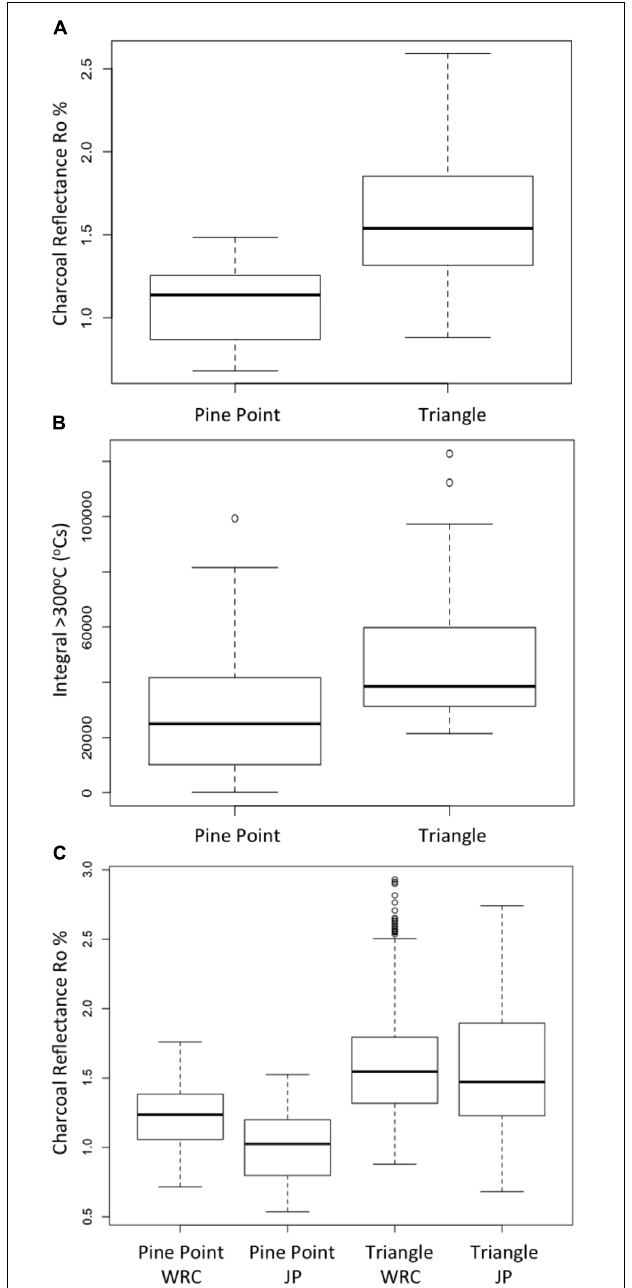
FIGURE 7 | Box plots ( n = 30 for each boxes) exploring the distribution of charcoal reflectance and the integral > 300 ◦ C for the fires at the Pine Point and Triangle sites, Canada (A) shows the range of reflectance values from WRC samples for the two sites. (B) Indicates the integrated area under the thermal couple curve > 300 ◦ C (as an estimate of energy flux to the fuel). (C) Shows charcoal reflectance variations between WRC and Jack Pine (JP) ( Pinus banksiana ) for both sites.